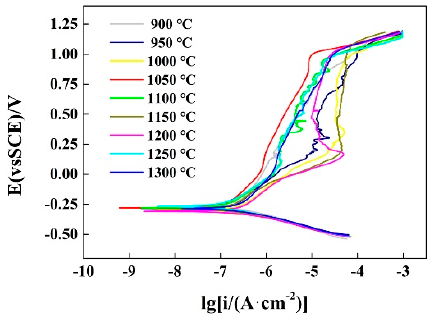
Figure 15. Polarization curves of UNS S32750 solution treated at different temperatures.